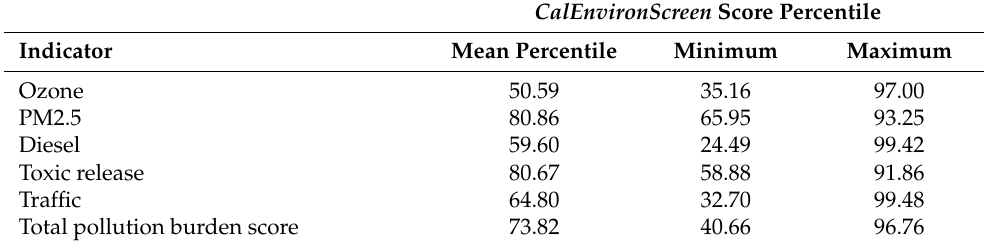
Table 1. Air pollution burden and demographic characteristics of 40 study participants residing in 36 census tracts in Los Angeles,